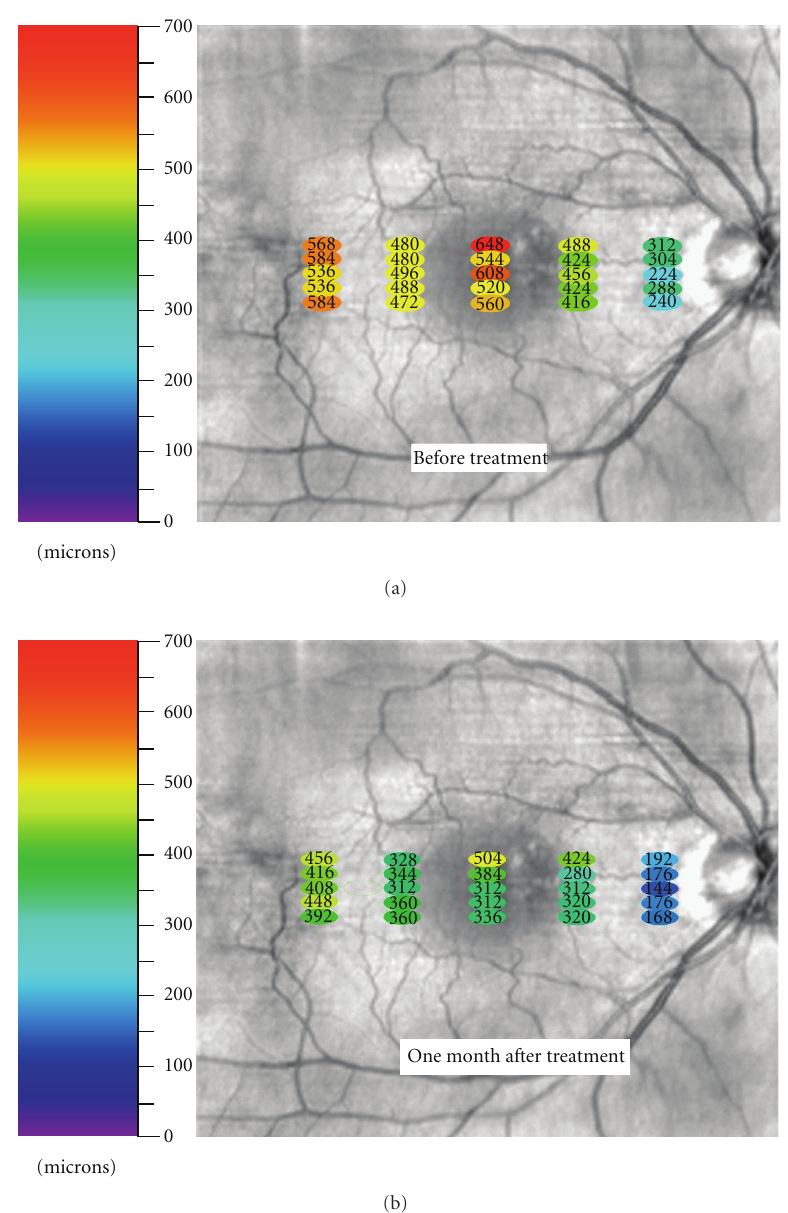
Figure 3: Fundus photograph of OD demonstrating thickness of choroid in microns at each specific measured point both before and after